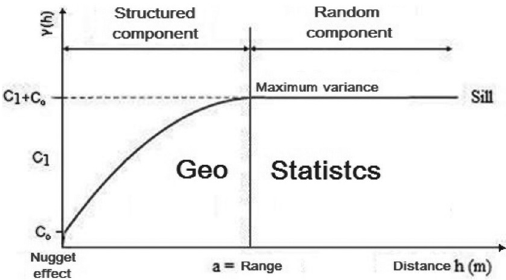
Figure 1. A semivariogram and its parameters: a (amplitude or range), C (variance), C 1 (= C + C ), (Guerra, 1 0